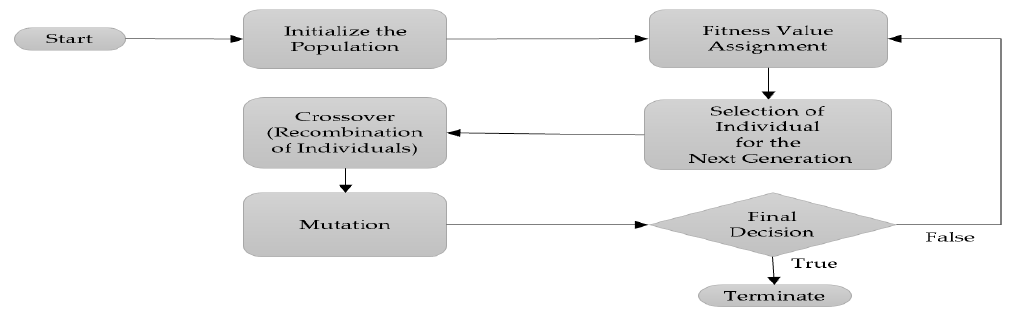
Figure 4. The flowchart of genetic algorithm implementation.